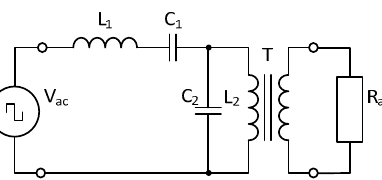
Figure 1. Simplified equivalent circuit of resonant tank for LCCT converter.